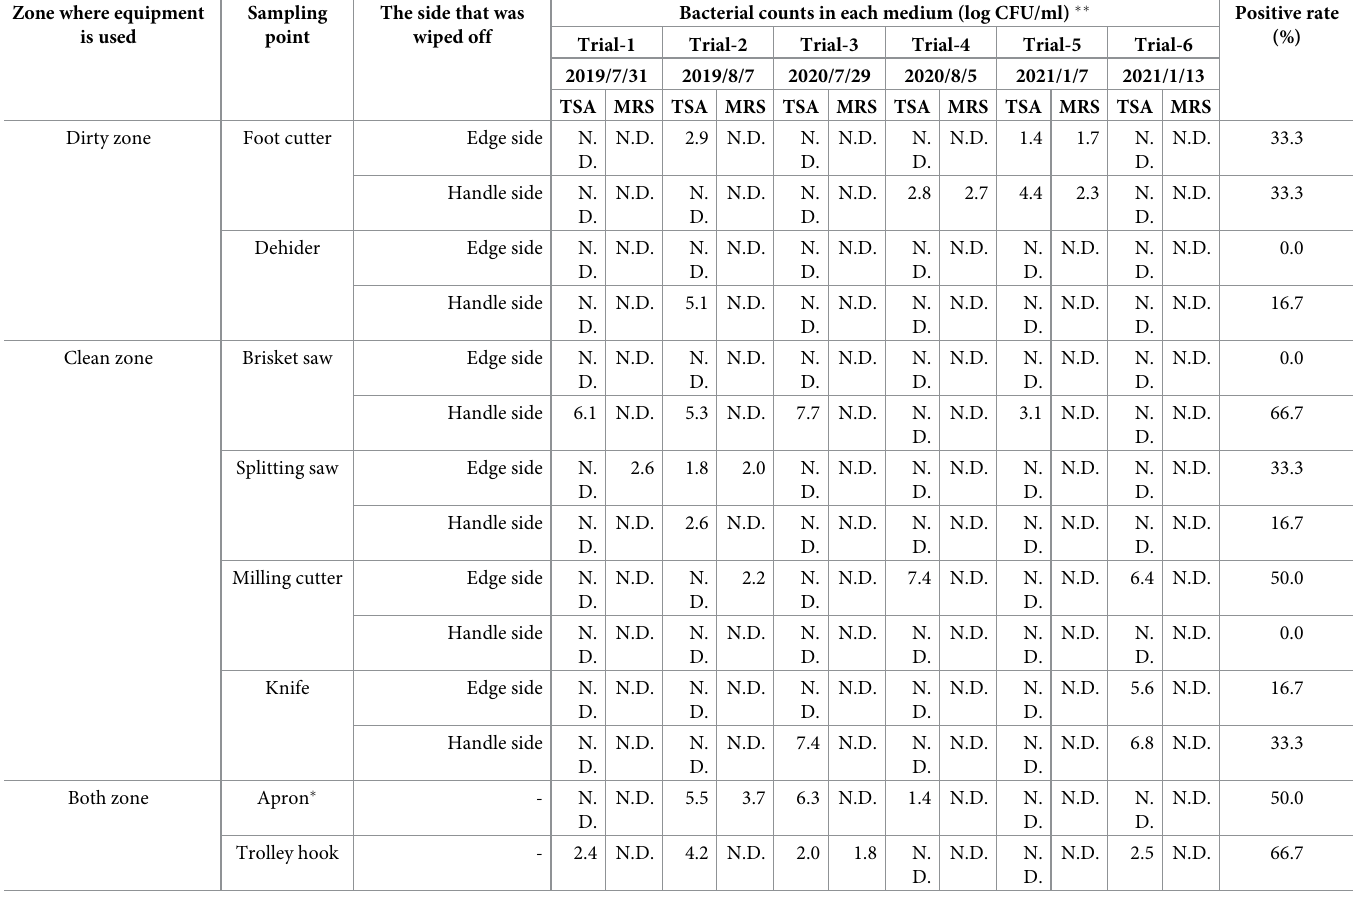
(handle side), were found to have microbial adherence in at least one trial (Table 1). Escheri- chia coli and coliform bacteria, both of which are mesophilic bacteria, were not detected in any of the trials from the equipment used in the slaughter and boning lines. Among the equipment Table 1. The number of psychrophilic microorganisms adhering to equipment used in slaughtering lines. Zone where equipment is